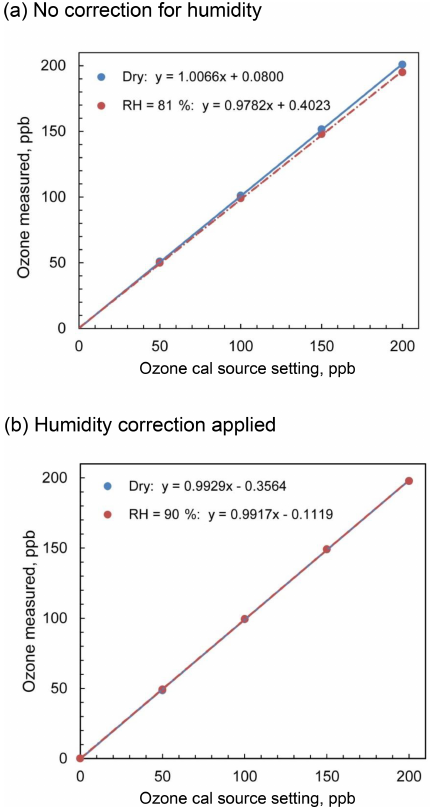
Figure 7. Comparison of the output of the Model 306 Ozone Cal- ibrator for dry and humid air for (a) no firmware corrections for humidity and (b) firmware corrections applied based on inline hu- midity